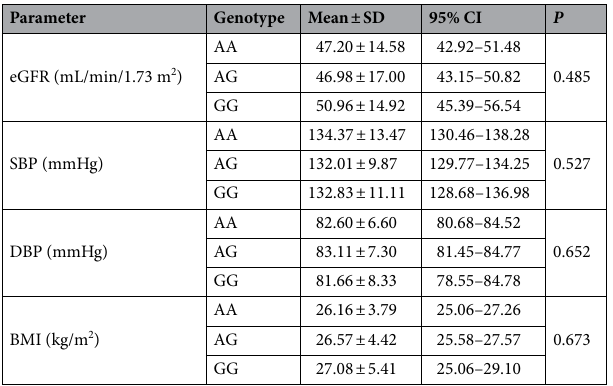
5. Analysis of the selected clinical par−ameters and biochemical parameters of the renal profile in relation to the genotypes of CTLA4 +49A>G polymorphism (rs231775). (CsA-12 h, n = 183), (TAC-12 h, n = 53), (TAC-24 h, n = 156). Values normally distributed are expressed as means ± standard deviation (SD). P-significance level for the difference between the groups (one-way ANOVA). BMI body mass index, eGFR estimated glomerular filtration rate, SBP systolic blood pressure, DBP diastolic blood